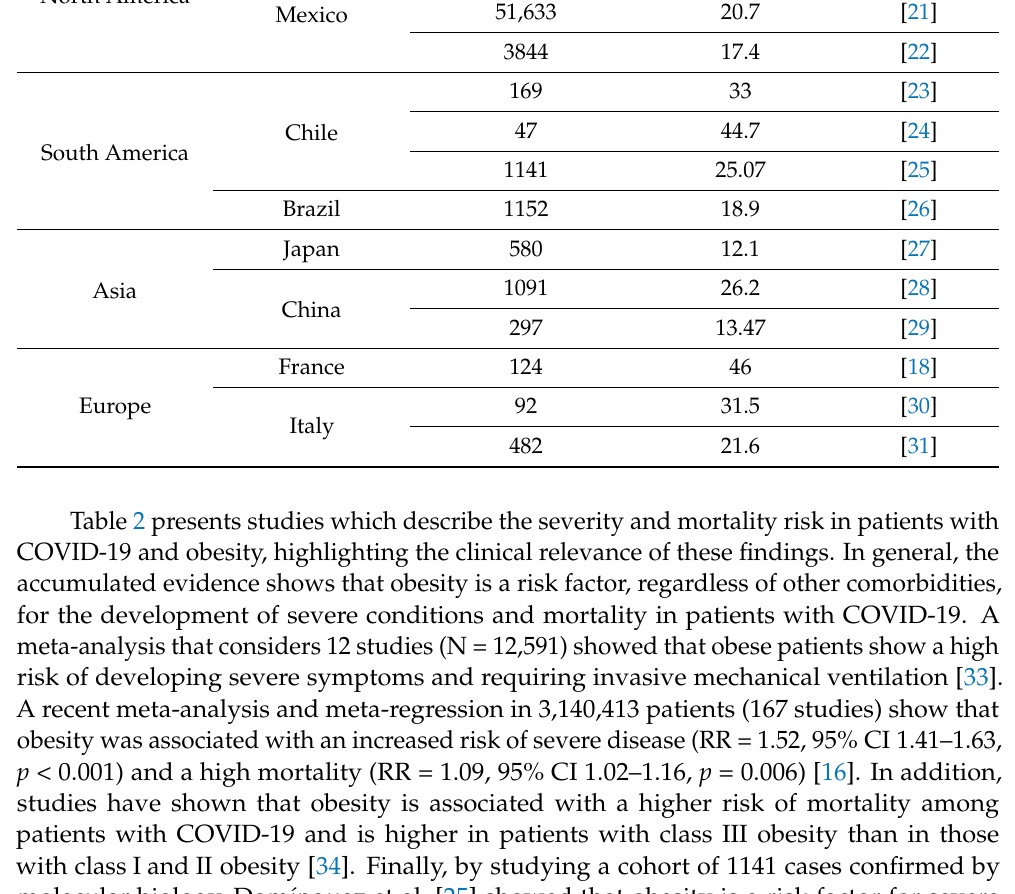
Table 1. Frequency of obesity in patients hospitalized for COVID-19 in various geographic regions. Continent Country Total Patients, N